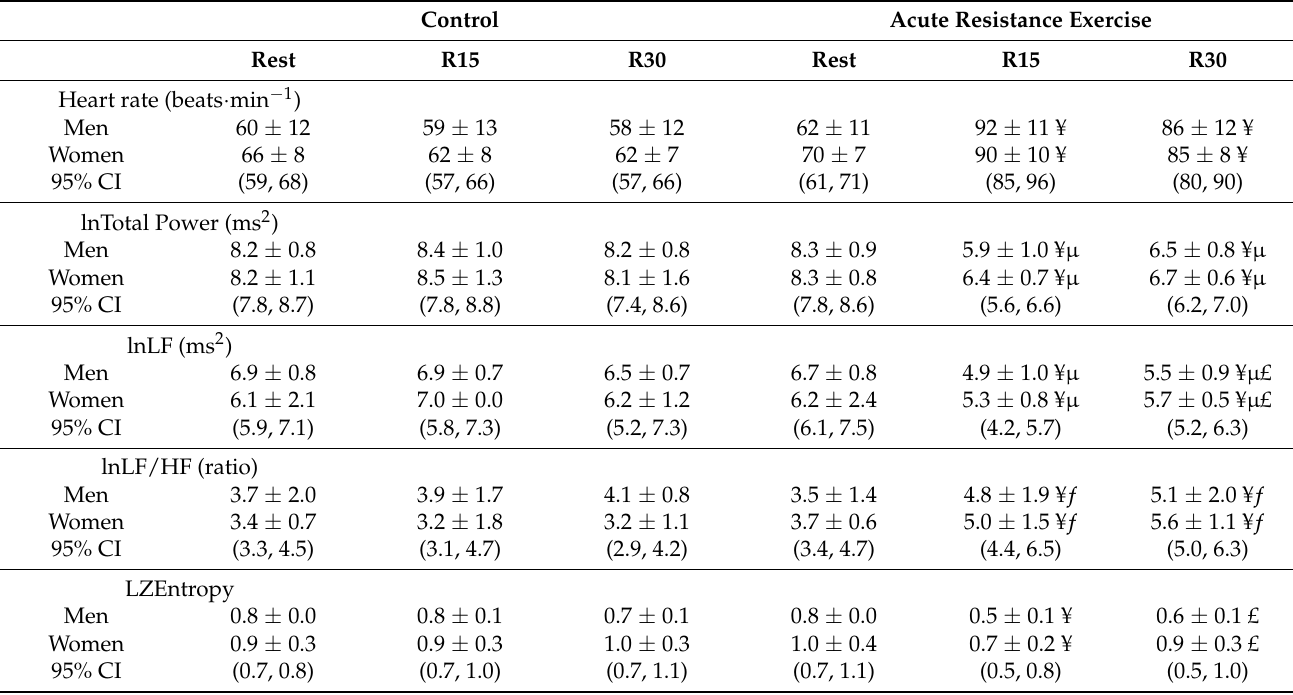
Table 3. Heart rate and autonomic modulation at rest and during recovery from a control and an acute bout of resistance exercise at 15 min (R15) and 30 min (R30) in active men and women (n = 21).